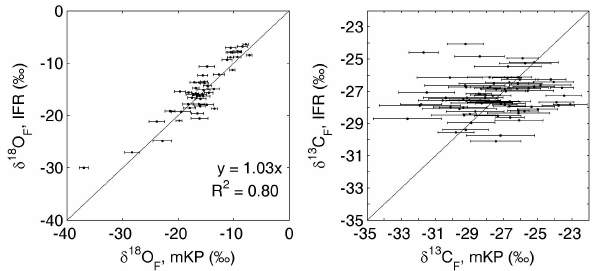
Fig. 6. Relationship between half-hourly isotopic ratios of the CO 2 flux near the forest floor ( δ 18 O F , δ 13 C F ) estimated using Keeling plot ( ± standard error of intercept) and isotopologue ratio method in the understory of a deciduous forest.